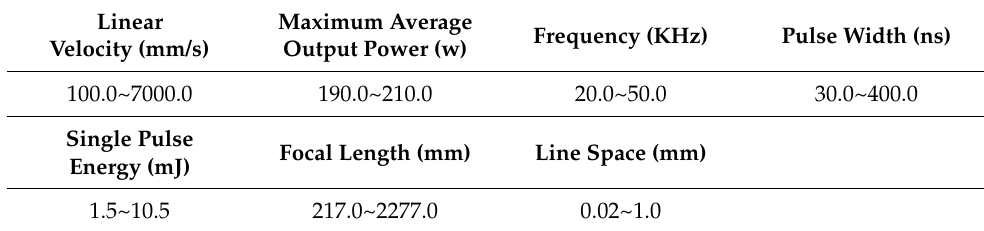
Table 5. The basic parameters of fiber laser in our experimental system.